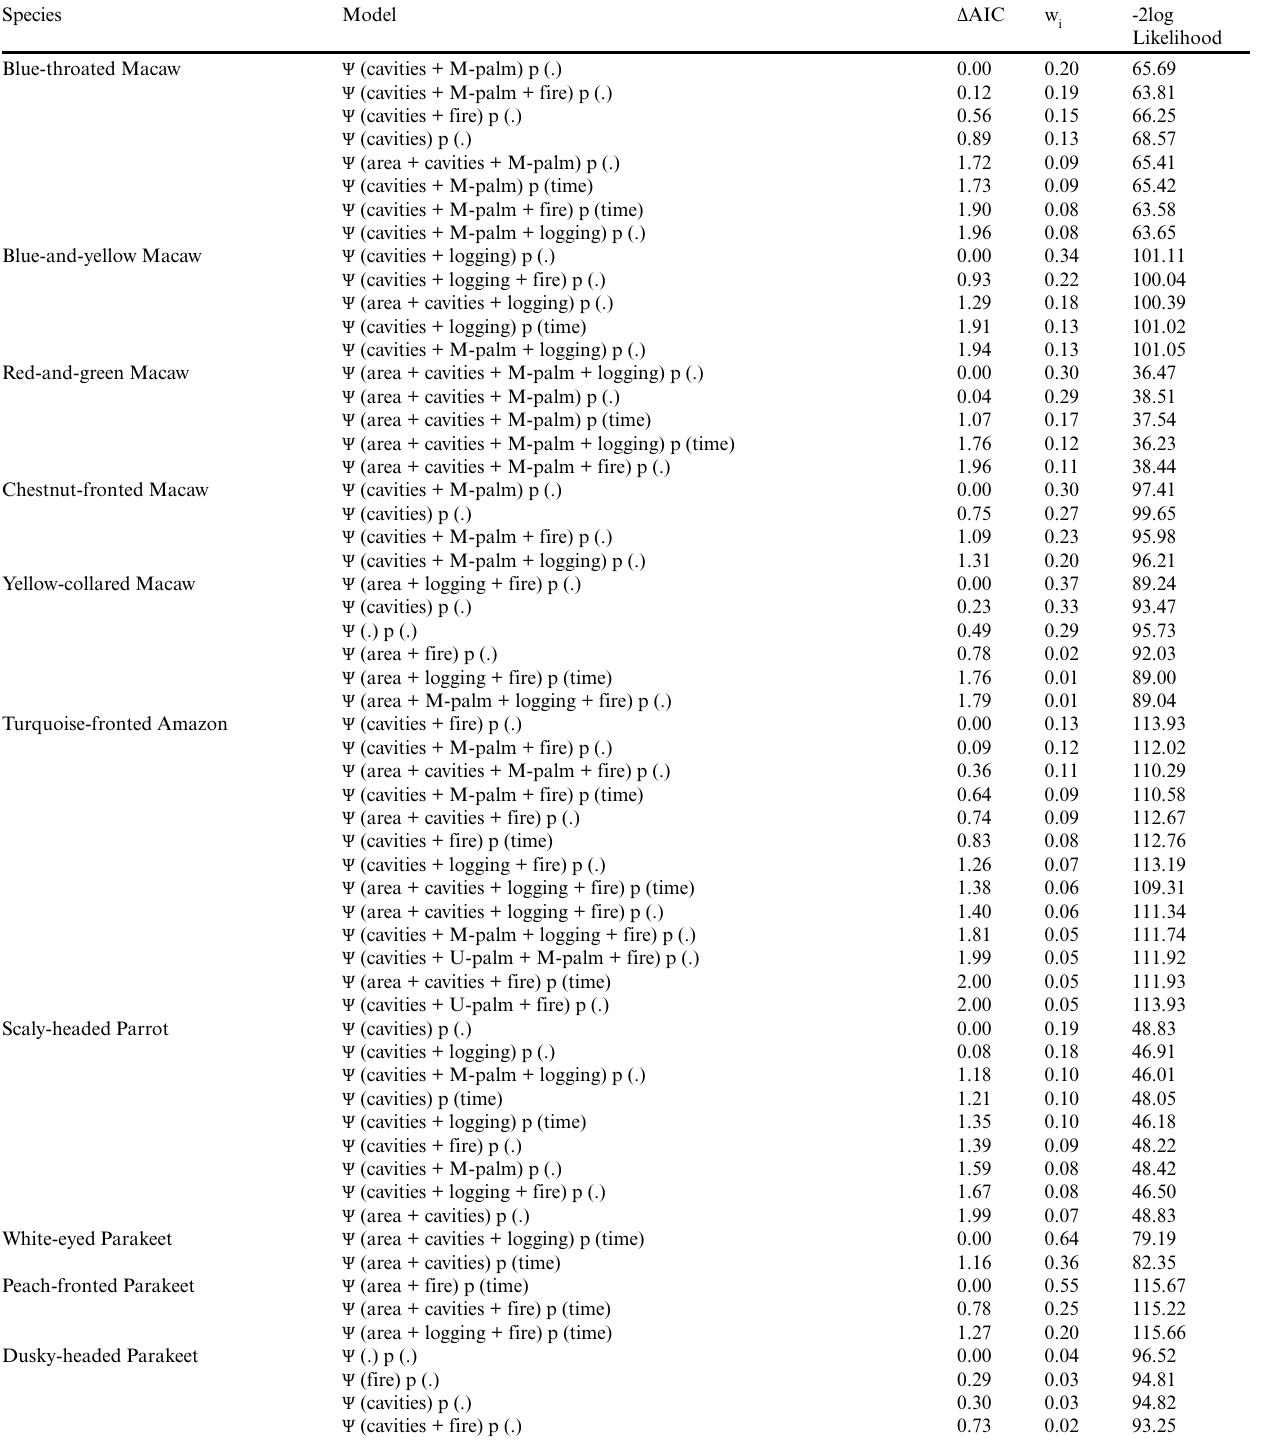
-2log i Likelihood